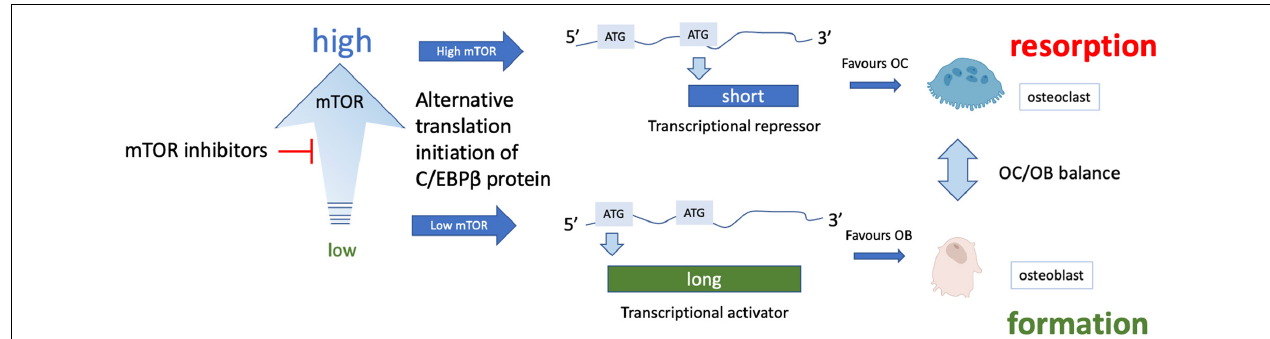
FIGURE 4 | Effect of mTOR inhibition on osteoclast/osteoblast balance. Various isoforms of the transcription factor C/EBP β can be translated from the same mRNA through translational skipping (also known as leaky ATG scanning) which is regulated by mTOR. Under conditions of high mTORC1 signaling, ATG skipping results in translation of a short isoform that is a transcriptional repressor, while lower mTORC1 signaling allows translation from an ATG toward the 5 (cid:48) end of the mRNA, forming a longer transcriptional activator form of C-EBP β (note only 2 isoforms are shown for simplicity). The long isoform is associated with osteoblast differentiation while the short isoform appears to promote osteoclast differentiation (for more details see Smink and Leutz, 2010).